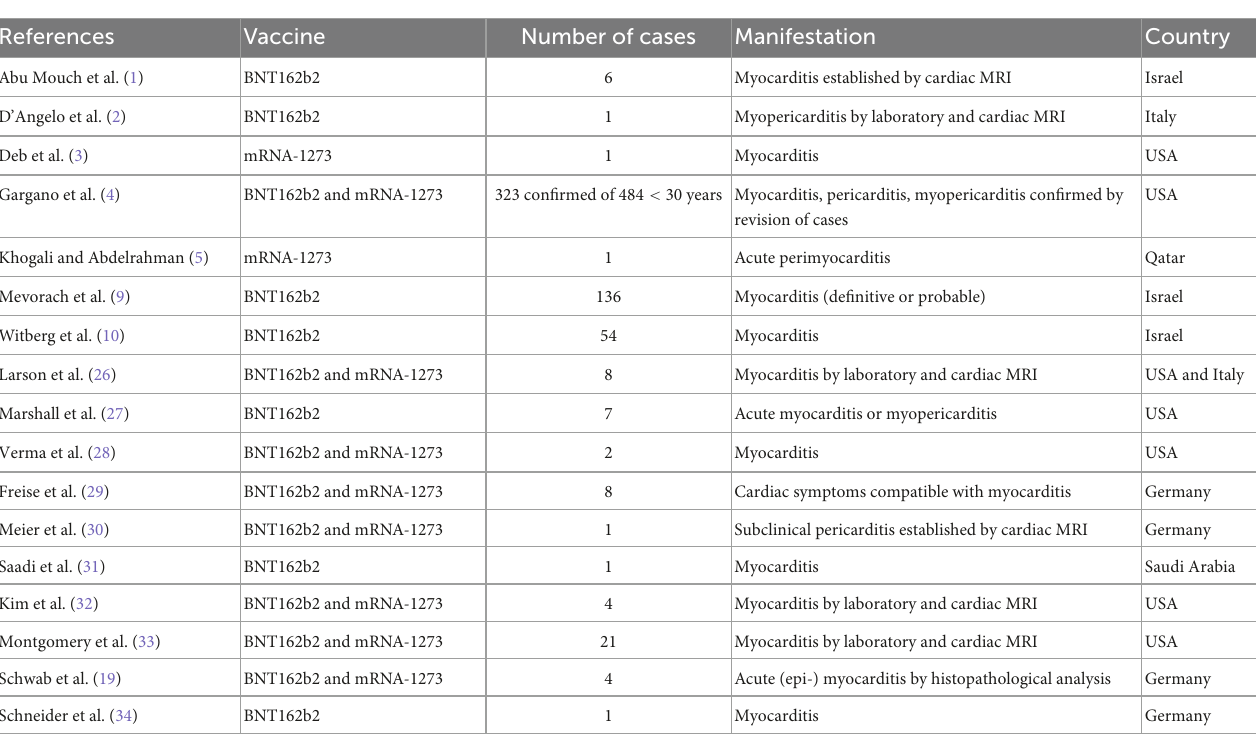
TABLE 2 Reports on cardiotoxicity of SARS-CoV2 mRNA